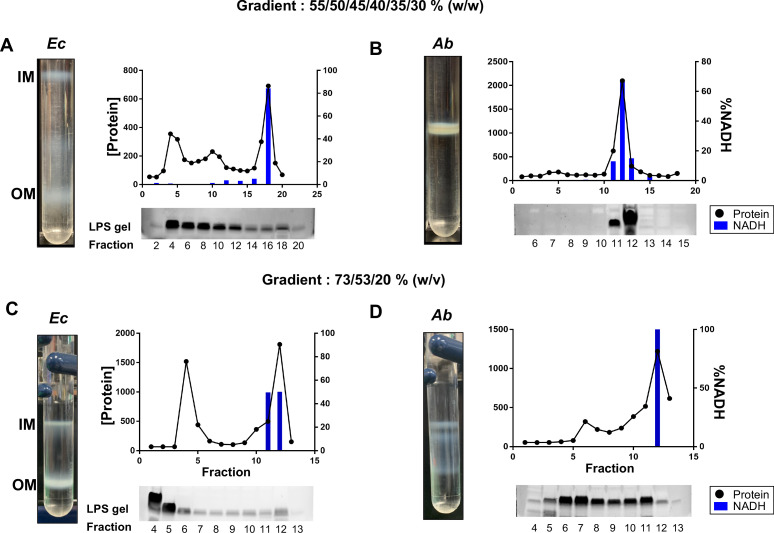
Membrane separations do not work in A. baumannii.(A) Left – Representative image of IM and OM separations of E. coli membranes using the protocol as designed by Osborn’s group. Right – Marker analysis. Graph displays protein content on the left y-axis with black circles and %NADH activity (IM-marker) on the right y-axis in blue bars across fractions for the entire gradient (x-axis). An SDS-PAGE gel stained for LPS (OM marker) is displayed immediately below the respective graph and numbered by fraction. (B) Left – Representative image of IM and OM separations of A. baumannii membranes using the protocol as designed by Osborn’s group. Right – Marker analysis as described above. (C) Left – Representative image of IM and OM separations of E. coli membranes using the protocol as described by the UW group. Right – Marker analysis as described above. (D) Left – Representative image of IM and OM separations of A. baumannii membranes using the protocol as described by the UW group. Right – Marker analysis as described above.